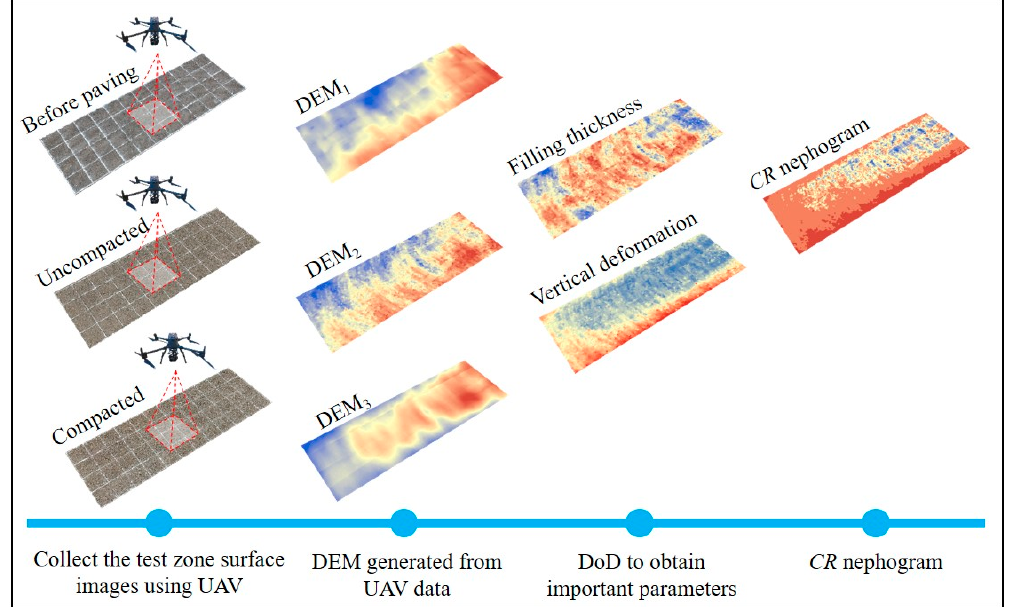
Figure 5. CR nephogram generation via UAV photogrammetry technology. After DoD processing, six phase CR nephograms were obtained. The data should be rendered to obtain a more intuitive compaction model that reflects CR information. According to the CR value, the nephogram was rendered in color, from red to blue, repre- senting the CR value from high to low. In Figure 6, the rendered data are beautiful and